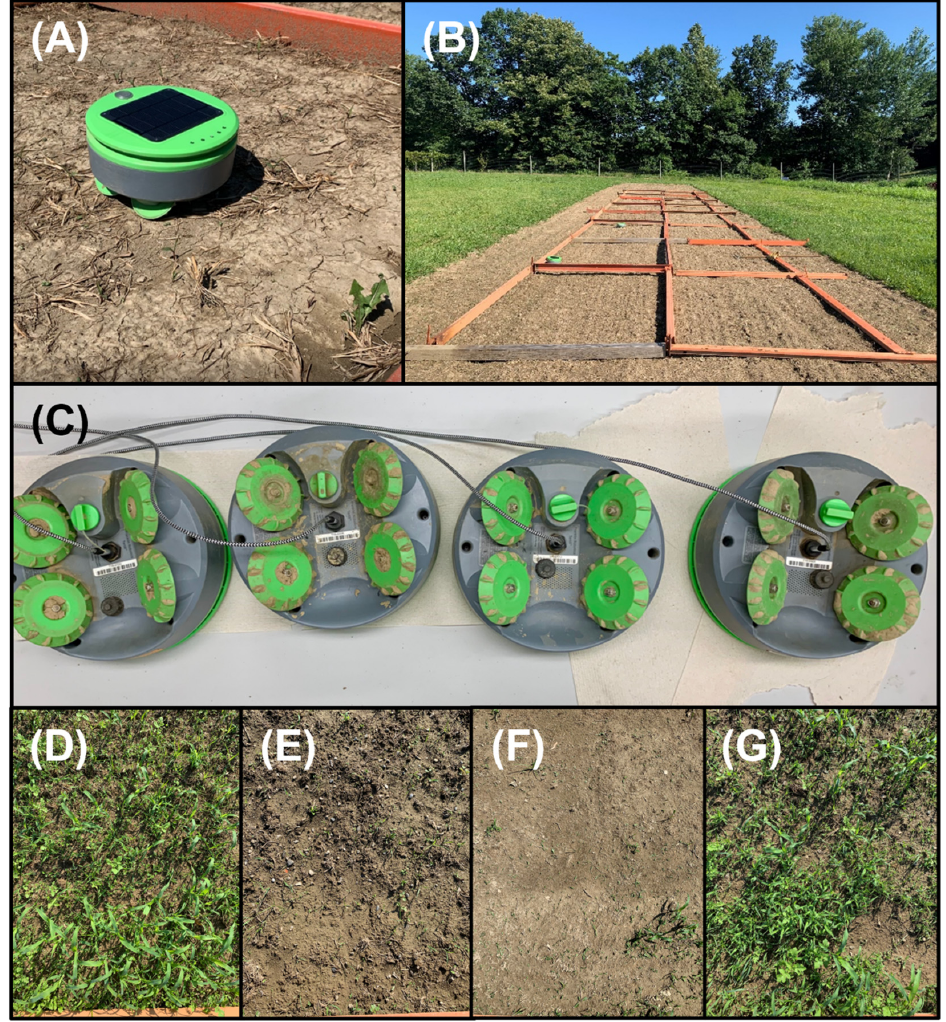
Figure 1. Tertill unit, experimental design, and plot photos. ( A ) Tertill travels in a random walk, using capacitive sensors to detect obstacles. Weed growth may be inhibited by its wheels and spinning string trimmer. ( B ) Old field site. Plots were 1.8 by 2.4 m. Four blocks of four treatments (T+, Tertill with trimmer; T − , Tertill without trimmer; HW, hand weeding by stirrup hoe; UWC, unweeded control) were set up at each location (old field and crop field) in Ithaca, NY. ( C ) Four Tertill units were used during the experiment. A pair of units [e.g., units 1 (T+) and 2 (T − ) from left] was used in each field during each weeding session. Tertill units were charged from an electrical outlet using the USB port on their undersides. ( D ) Representative UWC plot at the old field site on August 20. ( E ) Representative HW plot at the old field site on August 20. ( F ) Representative T+ plot at the old field site on August 20. ( G ) Representative T − plot at the old field site on August